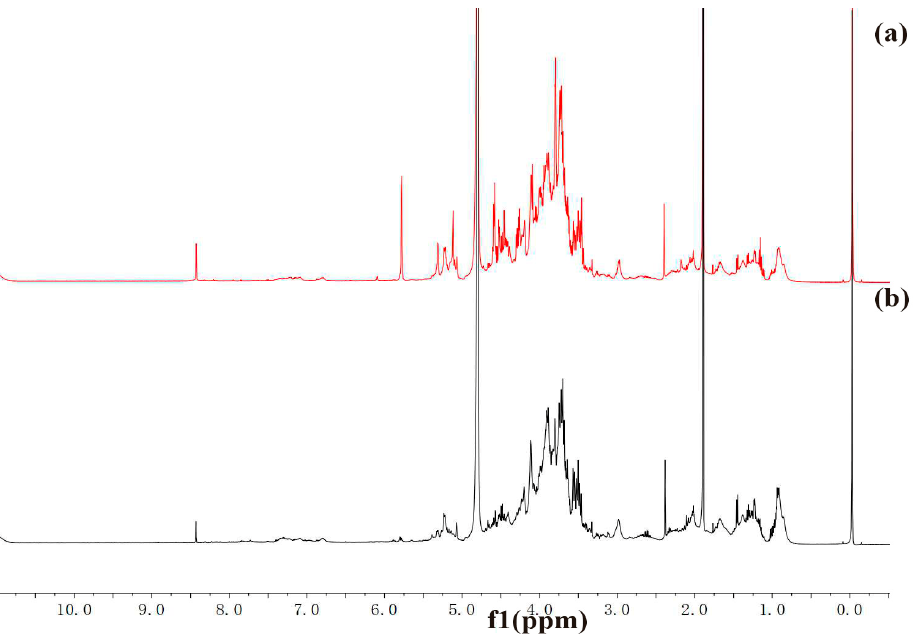
Figure 6. 1 H-NMR spectra of HAPS ( b ) and APS ( a ).